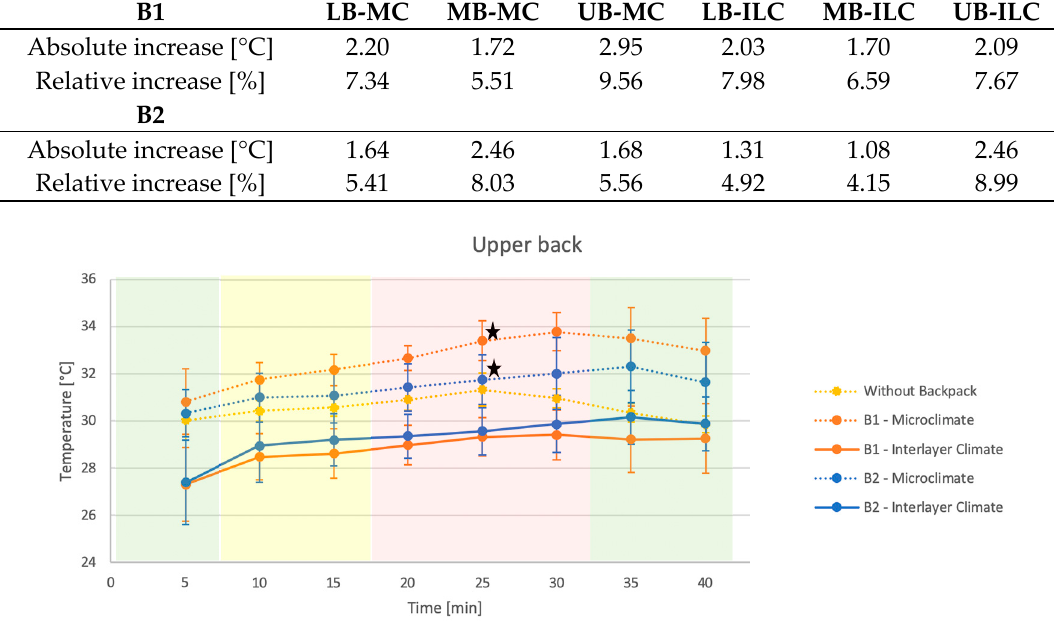
Table 2. Absolute and relative increase of the temperature at the lower back (LB), middle back (MB) and upper back (UB) in the MC and ILC from the beginning until the end of the exposure (30 min).